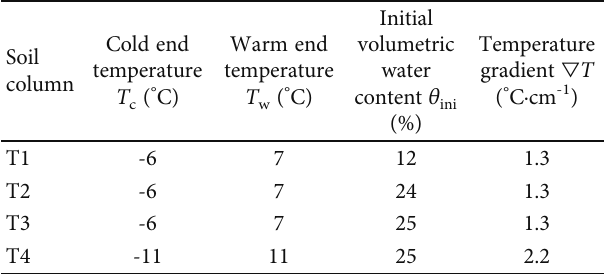
Figure 4: The experiment system composition schematic. Table 2: The soil column frost heave test